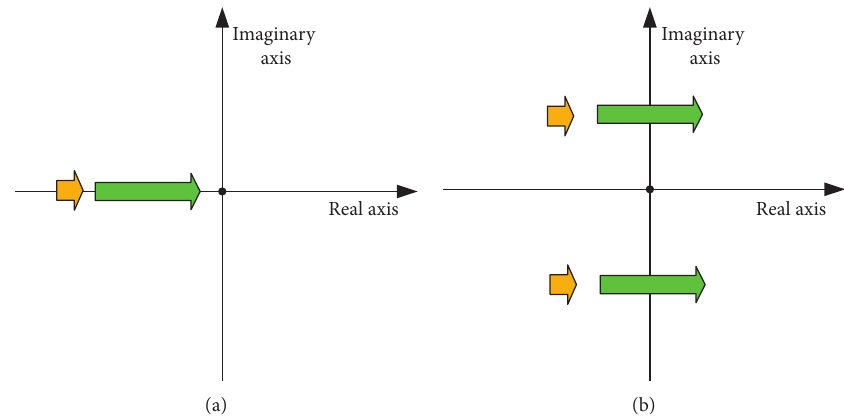
Figure 1: Variation of eigenvalues corresponding to the dynamic and static bifurcation points: (a) static bifurcation; (b) dynamic bifurcation.